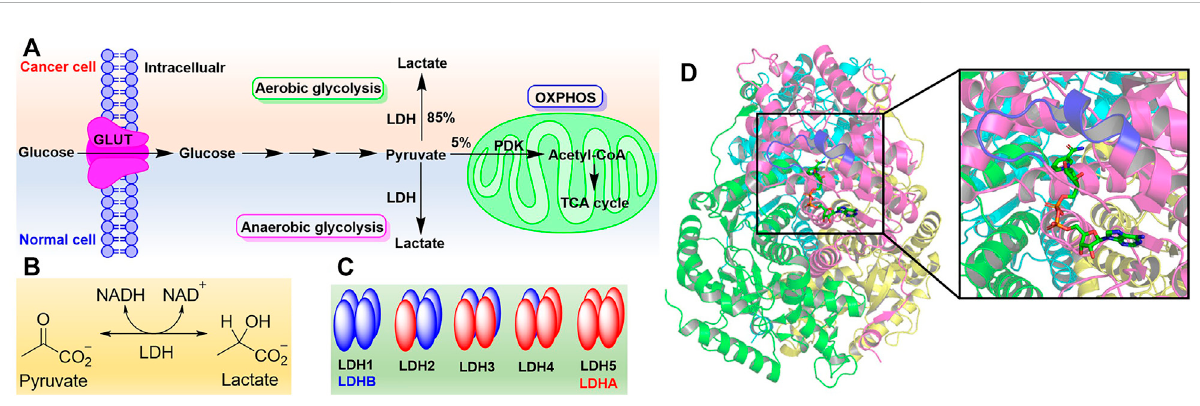
FIGURE 1 The Warburg effect and lactate dehydrogenase. (A) The Warburg effect. (B) Reaction catalyzed by LDH. (C) Isoforms of LDH. (D) Structure of LDH5 with the binding mode of NADH (PDB code 1I10). Four monomers (LDHA) wererendered with magenta, cyan, green, and yellow, respectively. Active site loop was highlighted in blue. NADH was shown as